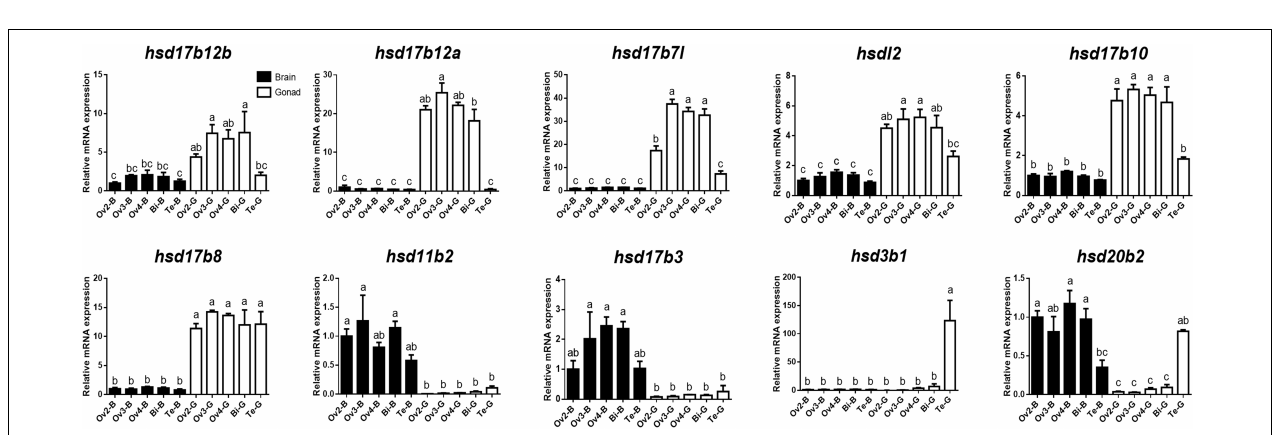
FIGURE 4 | Clustering of the expression profiles of 19 grouper β -hsd genes during sex reversal. Genes were clustered according to phylogenetic relationships in expression profiles. The RPKM values were transformed into Z scores. Z scores were plotted according to Z = (x - µ )/ σ , where x is the log 2 transformed gene expression measurement and µ and σ are the mean and standard deviations of expression of the gene. Red and blue colors indicate high and low relative expression levels after homogenization, respectively. The RPKM value for each gene and each stage was provided in the figure.